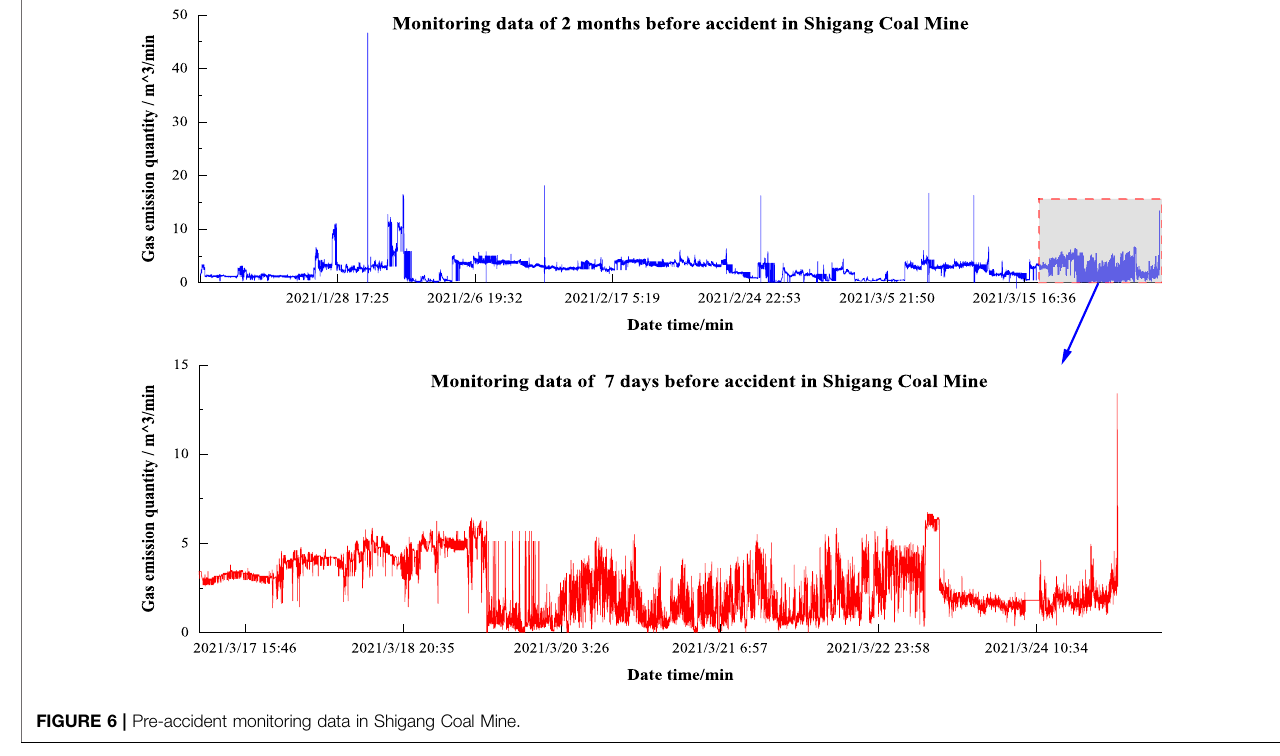
FIGURE 6 | Pre-accident monitoring data in Shigang Coal Mine.